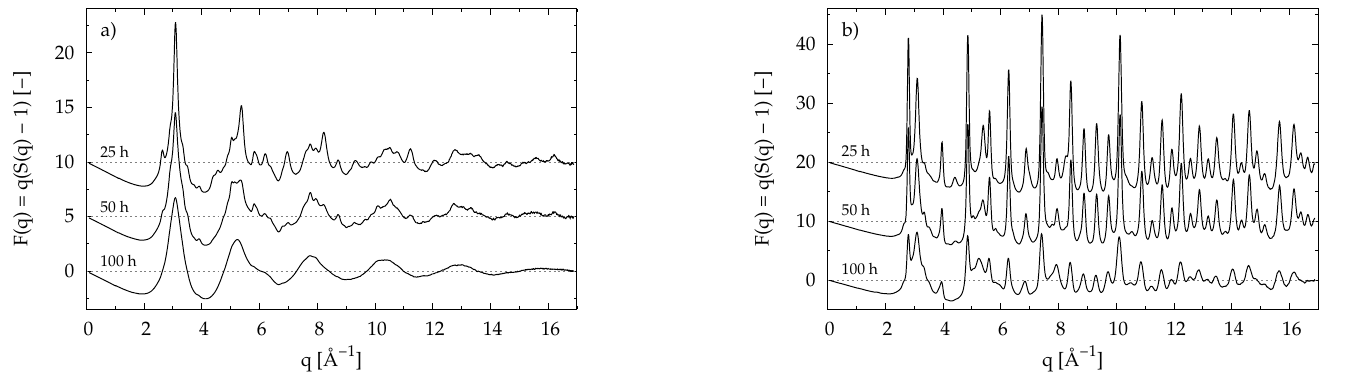
Figure 5. Room temperature q -weighted total structure factors F ( q ) for ( a ) CoFeTaB alloy and ( b ) CoFeWB alloy after 25, 50 and 100h of mechanical alloying. For better clarity, curves are vertically